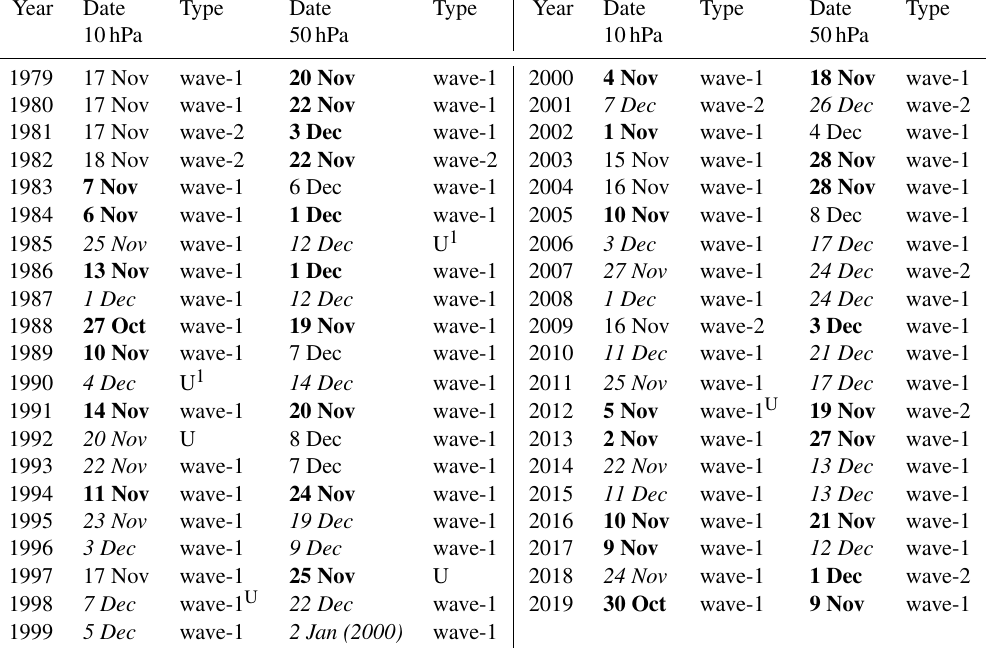
Table 2. Dates and classifications for FSW events in the Southern Hemisphere according to JRA-55 reanalysis. Early (late) events are indicated in bold (cursive), referring to a date before (after) the median date of 17 November at 10hPa and 6 December at 50hPa. Dates that fall within ± 2d of the median date are not classified as early or late. U = unclassified (methods did not agree according to the criterion outlined in Sect. 2). Superscripts indicate the ERA-interim classification if it was not in agreement with JRA-55 during the 1979–2018